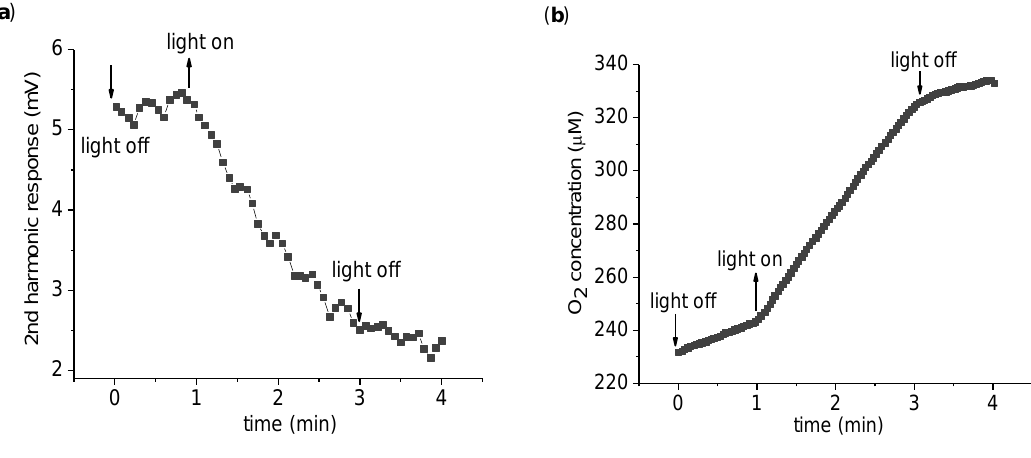
Figure 3. Continuous measurement of the 2nd harmonic response. (a) Time dependence of the 2nd harmonic response with a 3,072 Hz, 8 Vpp driving sinusoidal voltage. Every point is a 4 s average of the 2nd harmonic response. (b) The measurement of the O concentration 2 of the suspension was taken simultaneously with the 2nd harmonic response seen in (a). The measurement was carried out with 0.2 mg/mL chlorophyll in 5 mL suspension buffer with 1.0 mM K Fe(CN) as described in the text. The O concentration increases in the 3 6 2 dark due to O absorption from the atmosphere. 2